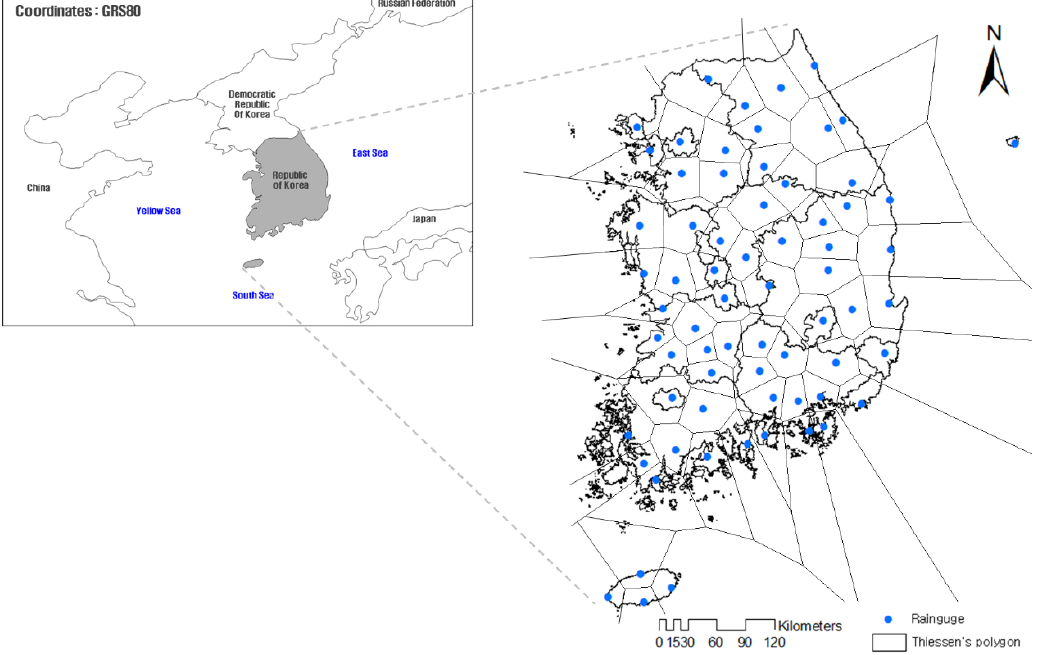
Figure 3. Local rainfall observatories and Thiessen’s polygon.